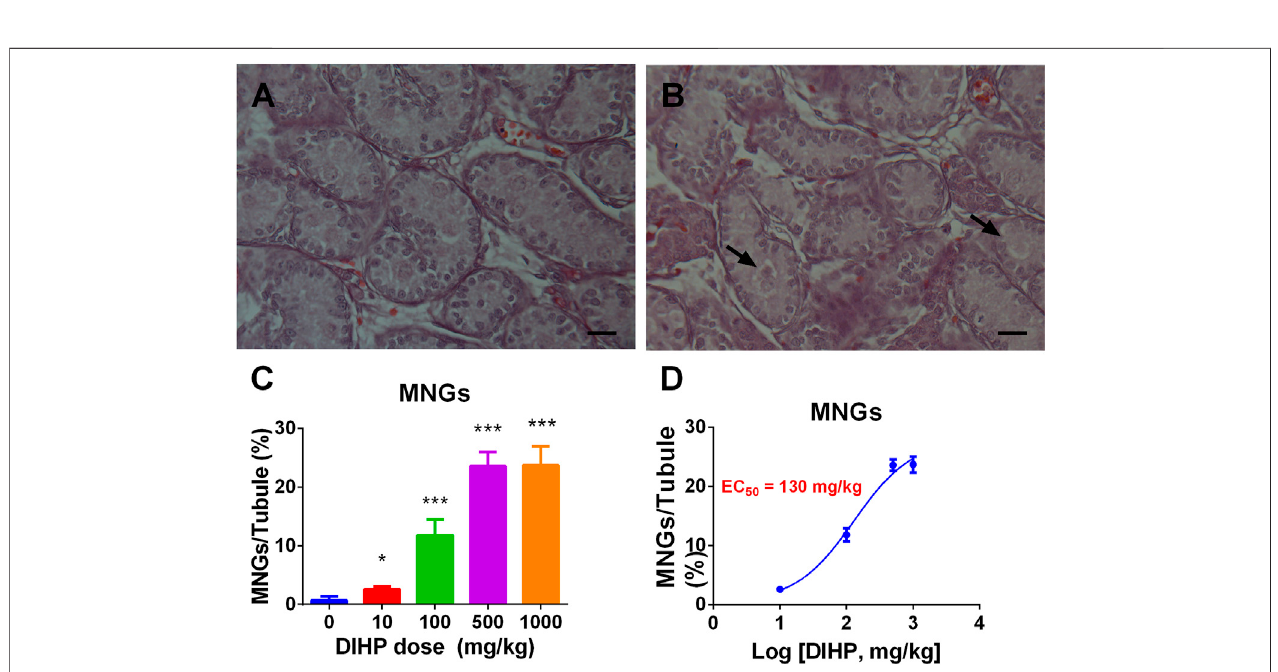
FIGURE 6 | Effect of DIHP on the formation of multinucleated gonocyte (MNG). From GD 12 to GD21, 0 (control), 10, 100, 500, and 1,000 mg/kg DIHP were administered by gavage to dams. Measurements were made on GD 21. (A, B) : The arrow of the HE stained image of MNG at 0 and DIHP 1000 mg/kg group indicates the MNG in the DIHP-treated testis. (C) Quantitative results; (D) IC 50 value. The data are expressed as mean ± SEM, n (cid:1) 6; * p > 0.05, *** p < 0.01 indicate that the signi fi cant level between the DIHP group and the control group, respectively.